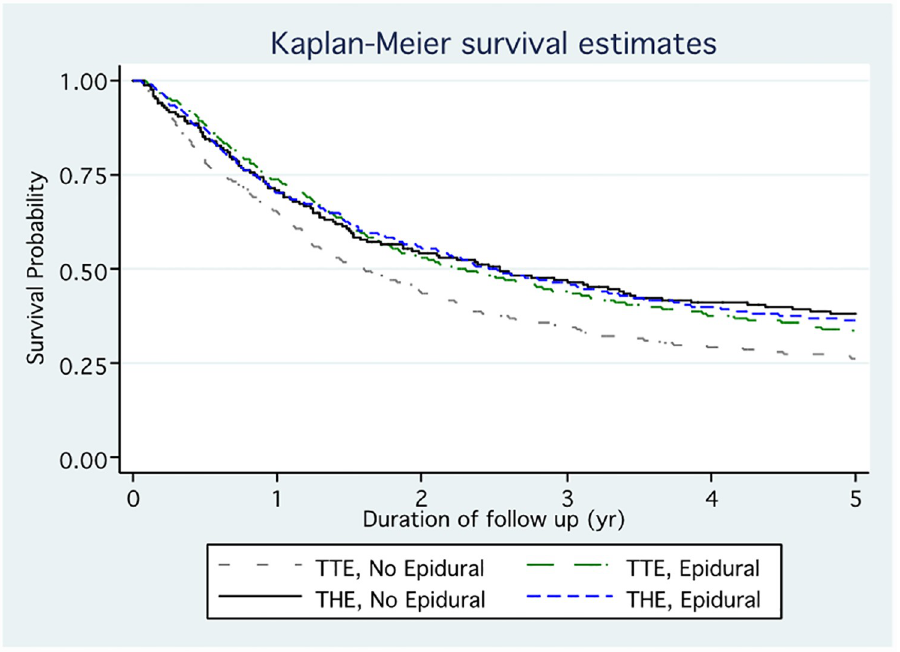
Fig 2. Kaplan-Meier overall survival curves for patients undergoing transthoracic or transhiatal esophagectomy with or without epidural analgesia.